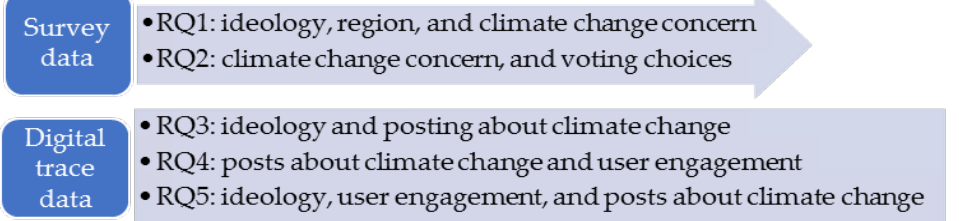
Table 2. OLS regression on concern about climate change and the environment in voting decisions. Concern about Climate Change